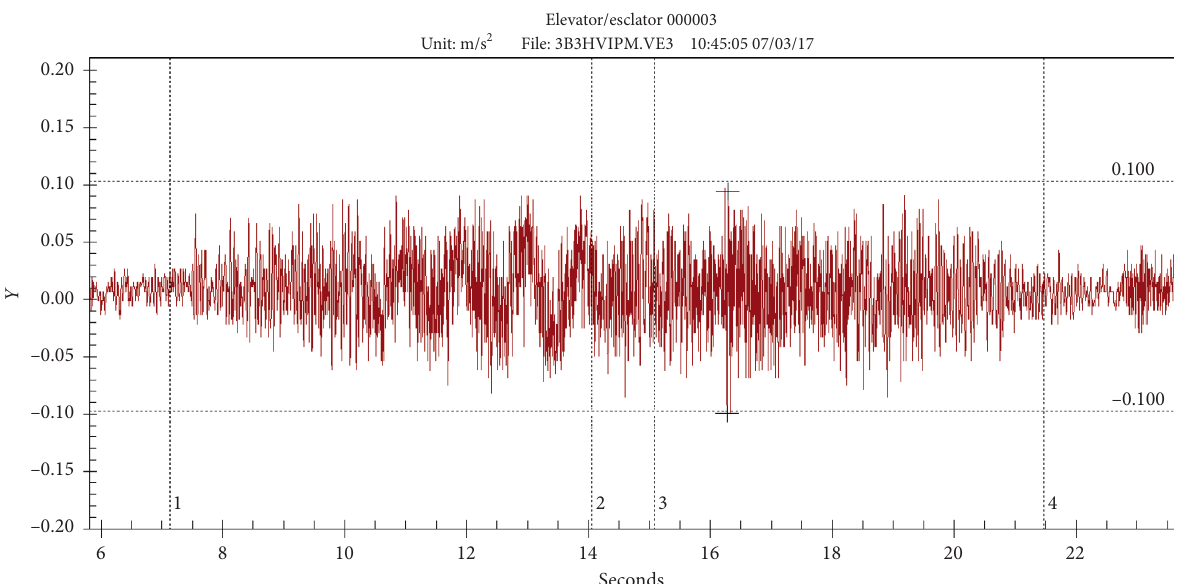
Figure 18: Horizontal vibration acceleration curve of the KLK2 high-speed elevator